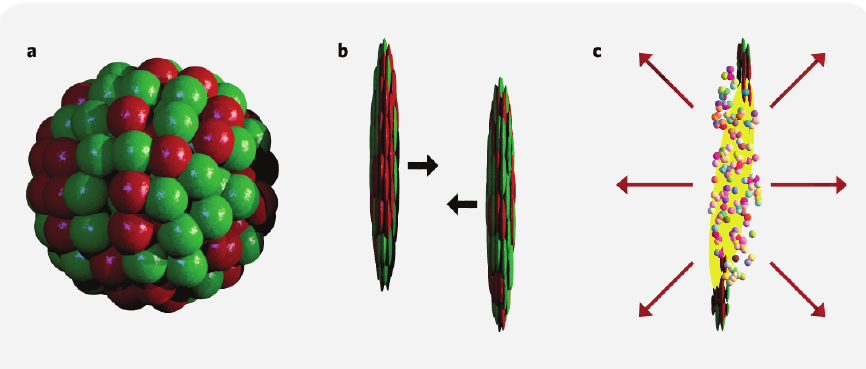
Figure 2. Heavy ion collision. In the Large Hadron Collider, nuclei of lead atoms (a) are accelerated to velocities so close to that of light that they are strongly contracted by Lorentz contraction. The actual contraction is even stronger than sketched in (b). When these collide (c), large numbers of particles are generated, occupying a tiny volume, so that, during a short period of time, the particle density is much greater than in the original nuclei. The exploding debris can now be